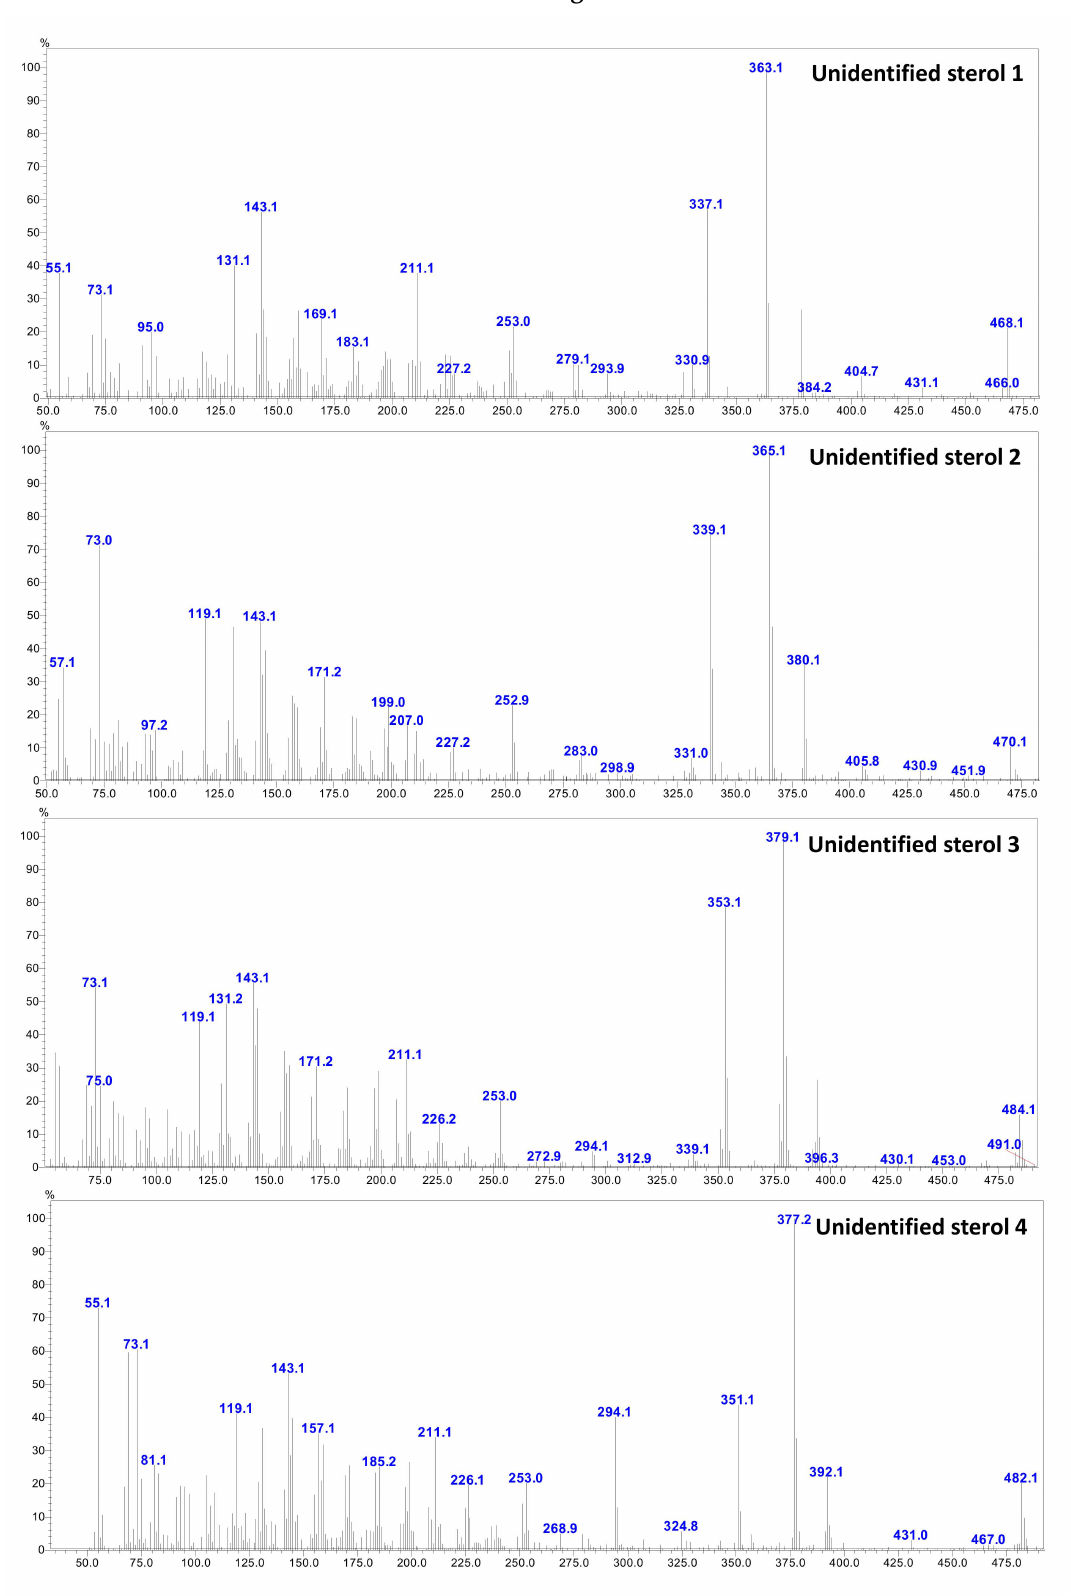
Figure A1. The mass spectrometric fragmentation pattern of unknown sterols observed in the present